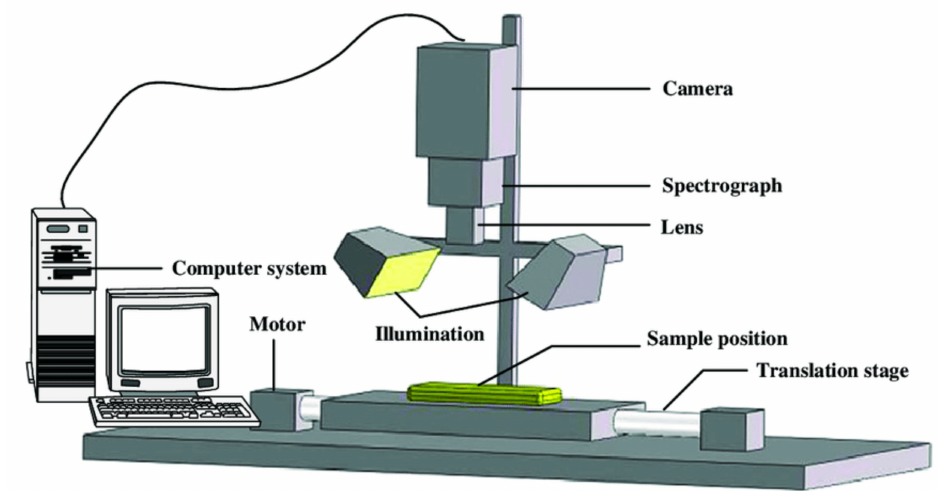
Figure 3. Schematic diagram illustrating the main components of a line-scan hyperspectral imaging system [87]. Reprinted with permission from ref. [87]. Copyright 2014 Elsevier.